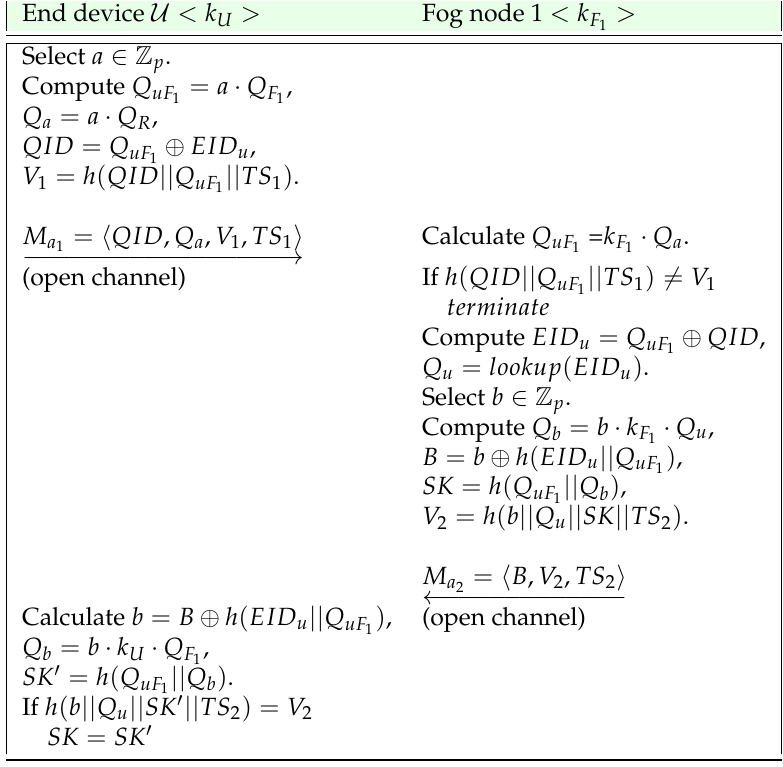
Figure 4. Summary of initial